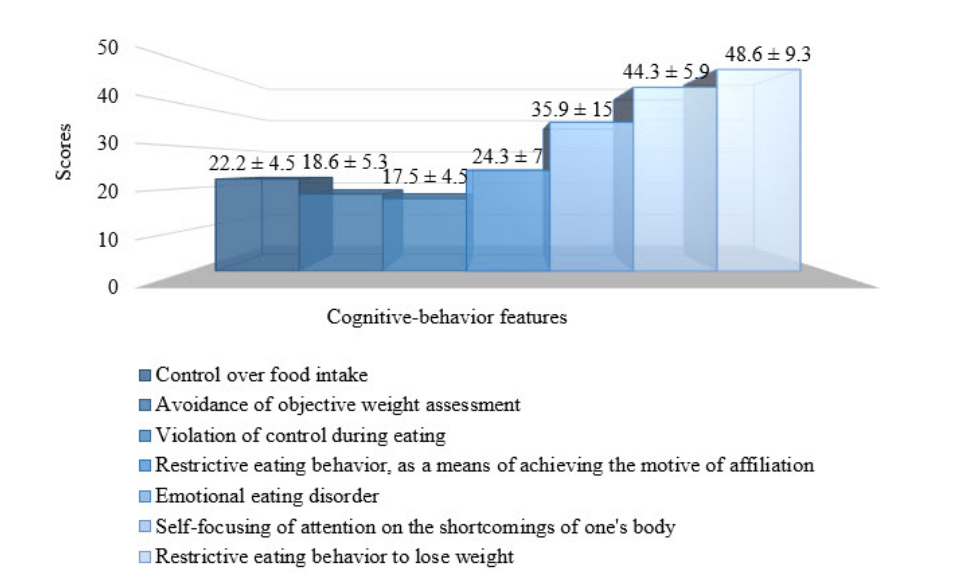
Figure 1. Mean values of the severity of cognitive features in individuals with anorexia